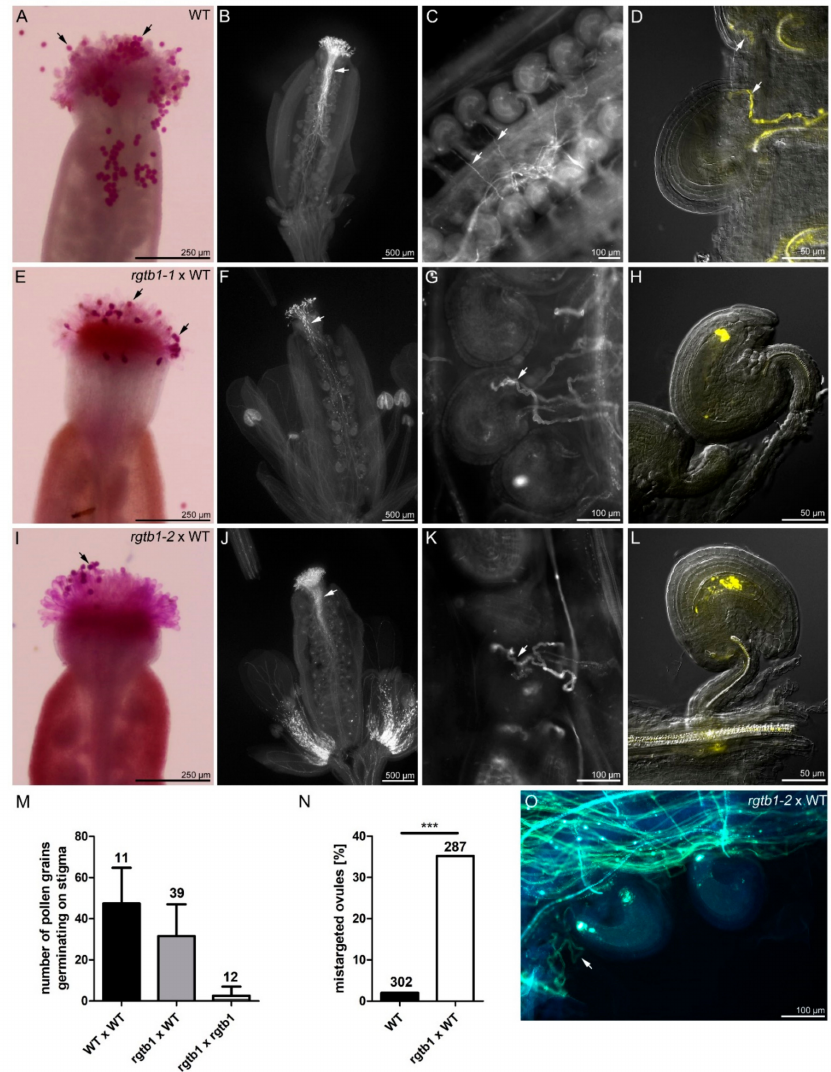
Figure 2. Pollen tube germination, growth and guidance are compromised in rgtb1 plants. Reception of pollen on stigma and growth of pollen tubes through the transmission tract and toward ovules in WT ( A – D ) and rgtb1 mutants ( E – L , O ). ( A , E , I ) Alexander-stained (purple) pollen on WT ( A ), rgtb1-1 ( E ) and rgtb1-2 ( I ) stigmas, 4 h after hand pollination (4HAP) with WT pollen (black arrows). Most mutant grains hydrated and germinated, although the capacity of the rgtb1 stigma to attach WT pollen was decreased in comparison to WT stigma reception ( E , I ). Scale bar 250 µ m, common to images ( A , E , I ). Quantification of pollen grains germinating on stigmas, bars show mean ± SD of pollen grains germinating per stigma; number above bars describe number of stigmas counted per experimental cross. Genotypes used for each cross are given in the bar description; pollen donor is given first and pollen acceptor second. ( B – D , F – H , J – L , O ) Pistils 8 h after hand pollination (8HAP) with WT pollen were stained with decolorized aniline blue to visualize callose. ( B , F , J ) Bundles of pollen tubes growing through the transmission tract; white arrows point to the WT pollen tubes growing in the WT transmission tract ( B ) or rgtb1 transmission tracts ( F , J ), scale bar 500 µ m, common to images ( B , F , J ). ( C , D , G , H , K , L , O ) Examples of pollen tubes growing toward the micropyle. ( C , D ) Normal WT pollen tube guidance in WT pistil. ( G , K , O ) More than one WT pollen tube twisting around the micropyle (white arrow) in rgtb1 pistils. ( H , L ) No WT pollen tubes approaching rgtb1 ovules of apparently normal size and integument shape, but showing a callose plug at the site of the egg apparatus. Scale bar 100 µ m in ( C , G , K , O ) and 50 µ m in ( D , H , L , N ), quantification of incorrect WT pollen tube guidance to the micropyle in rgtb1 mutant transmission tract. ( M ) Quantification of pollen grains germinating on stigmas. Pollen grains forming pollen tubes were counted on stigmas stained with DAB (decolorized aniline blue) 18 h after hand pollination (18HAP). Bars show mean ± SD of pollen tubes germinating on a stigma. Number of pistils observed is given above the bars. Pollen acceptor is given as first, pollen donor as second in the graph legend. Numbers above the bars describe the number of ovules counted per genotype. Values were compared with a z -test for two proportions; *** denotes a p value <